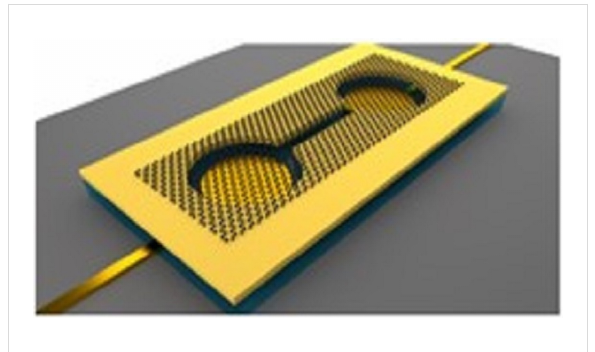
A pneumatically coupled graphene membrane pump was de- signed by Davidovikj et al. [78], which is selectively permeable to gases in a controllable way, as shown in Figure 9. The dumb- bell-shape chamber consists of a narrow trench connecting two circular cavities, both of which are covered by few-layer graphene. Local electrodes at the bottom of each cavity allow to drive each graphene membrane individually, changing the pres- sure of the chamber through a small voltage and controlling the airflow between the two cavities. The system can also be used for molecular sieving of gases and the aspiration and dispensing of liquids by introducing pores in the graphene membranes.